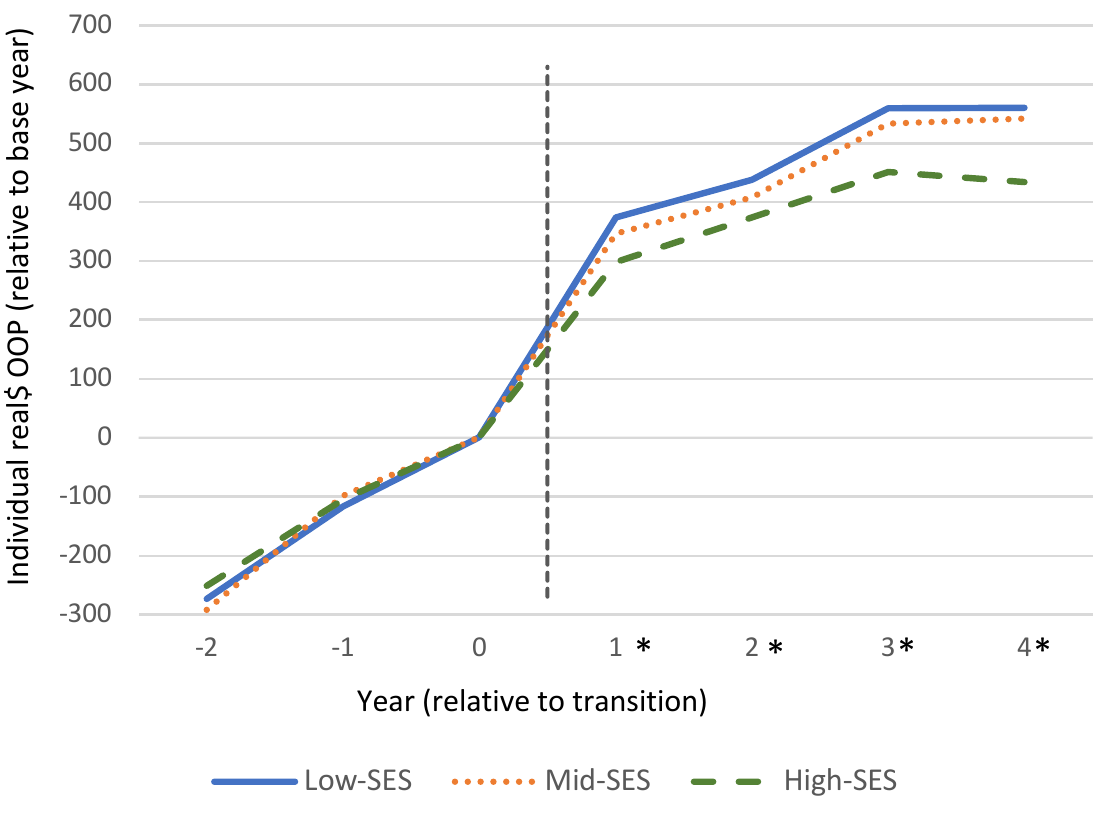
Figure 6: Conditional quantile regression estimates of effect of choice devolution among high-cost enrollees at the 95th percentile of the OOP distribution. Notes: This figure shows conditional fixed effects quantile regression estimates of differential changes in OOP medical expenditures at the 95th OOP percentile at firms that transition to devolved choice. SES categories correspond to the bottom 25 percent, middle 50 percent, and top 25 percent of the sample distribution. The model is estimated with year-fixed effects and with person-fixed effects centered at the pre-devolution level. ∗ indicates a statistically significant difference between the high- and low-SES groups at p <